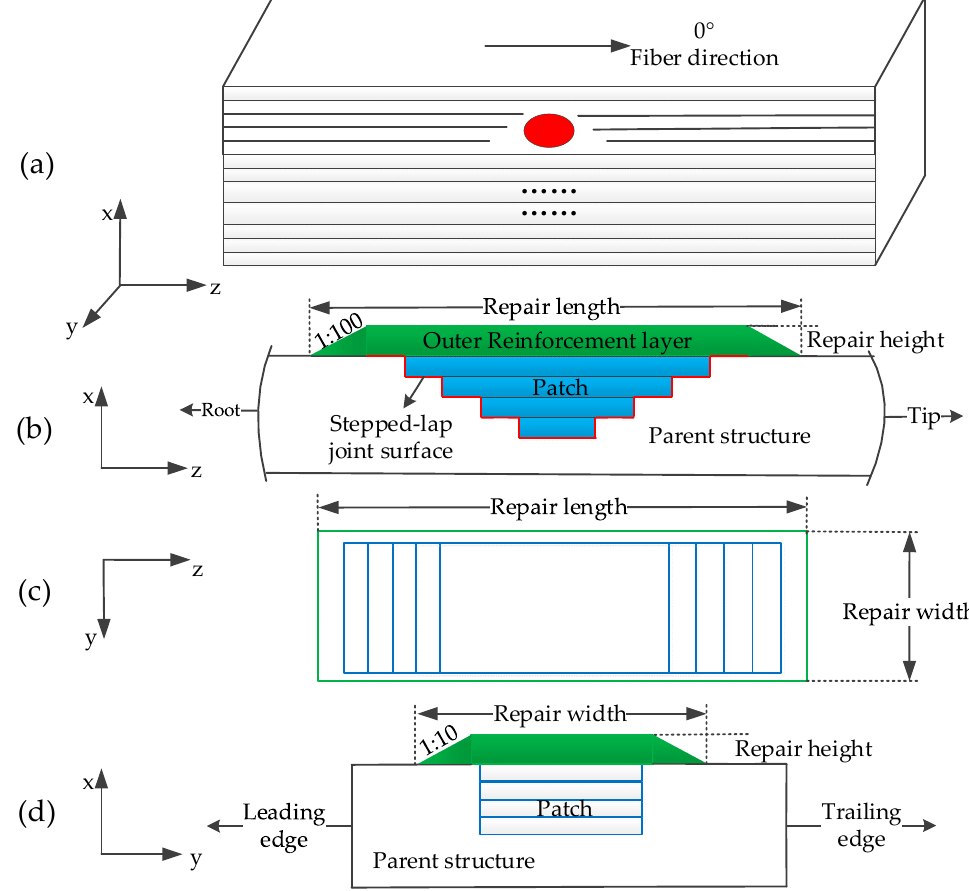
Figure 2. Repair parameters of the ORLs: ( a ) structural damage of spar cap; ( b ) front view—repair length and repair height; ( c ) top view—repair length and repair width; ( d ) side view—repair width and repair height.